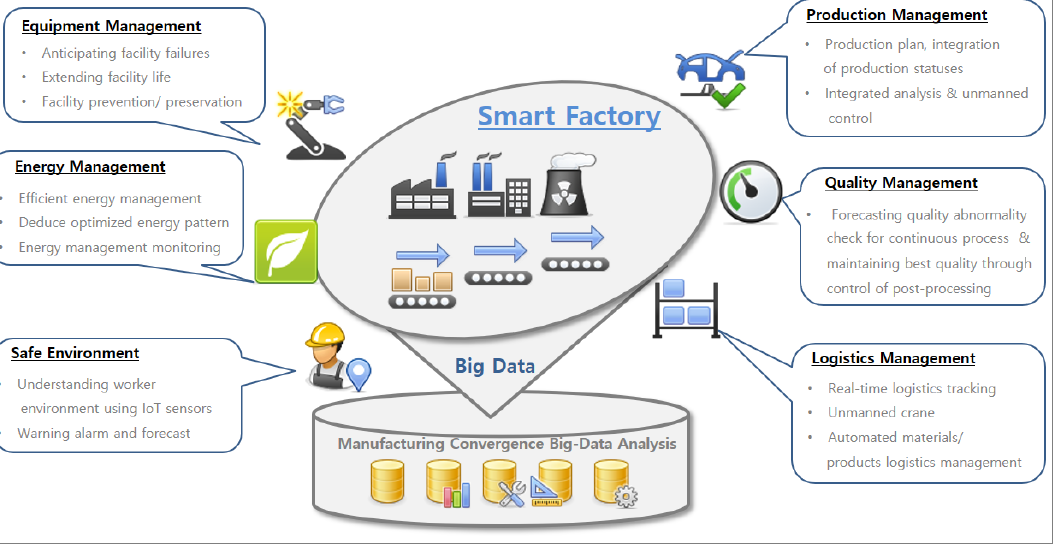
Figure 2. The configuration of an ICT ‐ based smart factory.